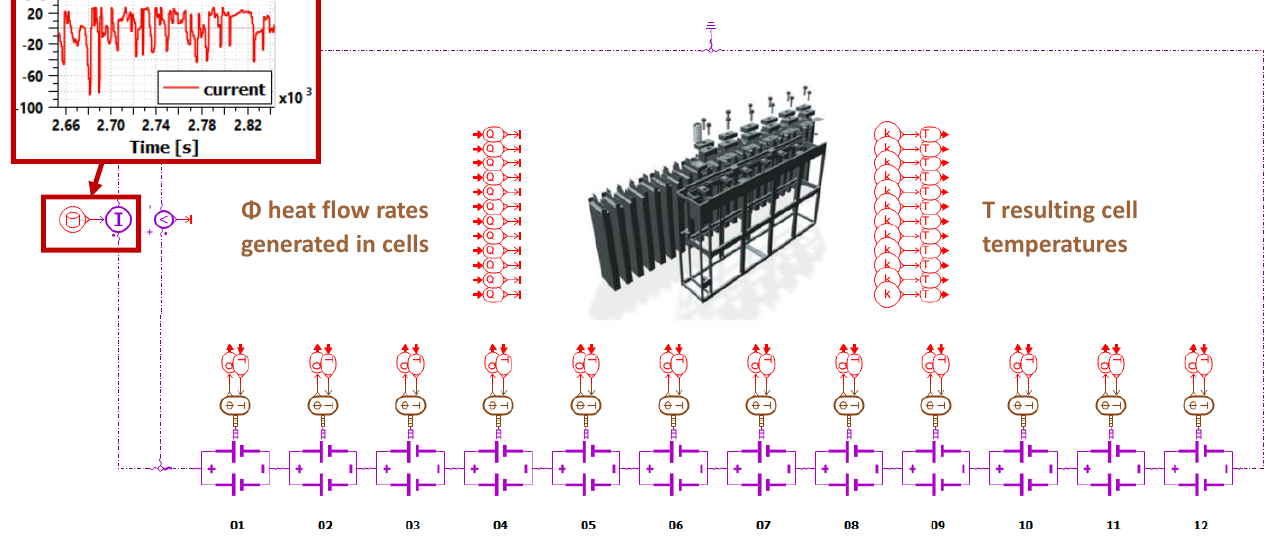
Figure 6. System simulation battery stack model.